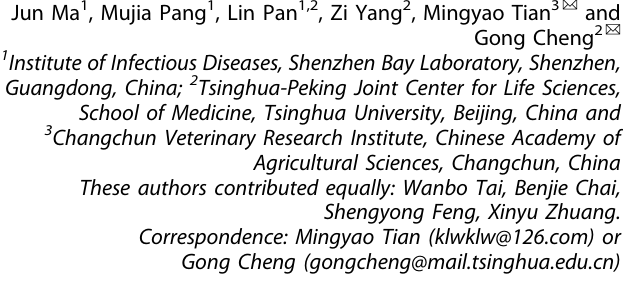
Fig. 1 Development and characterization of the FNP-Fc-RBDOmicron vaccine against SARS-CoV-2 Omicron variant. a Schematic representation of a SARS-CoV-2 Omicron RBD with Fc tag (light green), a ferritin-based 24-meric nanoparticle with N-terminal protein A tag (green), and an FNP-Fc-RBD Omicron complex. b The FNP complex was analyzed by SDS-PAGE. c Size distribution of the FNP complex was detected by DLS. d , e Interaction between Fc-RBD Omicron and FNP was detected by ELISA and SPR. An equal amount of ovalbumin served as a control. The data are presented as mean ± S.E.M. Statistical signi fi cance was calculated via ordinary unpaired parametric t test. f The FNP-Fc- RBD Omicron complex was analyzed by SDS-PAGE. g Size distribution of the FNP-Fc-RBD Omicorn was detected by DLS. h , i Measurement of IgG and neutralizing antibodies induced in immunized mice. The mice were immunized via intramuscular (i.m.) prime and boost at 2 weeks (10 μ g per mouse, n = 5). Sera at 14 days post-2nd immunization were detected for RBD Omicron -speci fi c IgG antibodies by ELISA. The neutralizing antibodies were assessed by live SARS-CoV-2 Omicron BA.1 virus. The data are presented as mean ± S.E.M. ( n = 5). Statistical signi fi cance was calculated via one-way ANOVA with multiple comparisons test. j Inhibition potency of immunized sera on SARS-CoV-2 RBD-hACE2 binding in hACE2/HEK293T cells. The inhibition potency was evaluated by fl ow cytometry. Inhibition percentage (%) was calculated by a relative fl uorescence intensity. k , l Splenocytes were stimulated with the RBD protein of Omicron. The IFN- γ and IL-4 secretion condition in splenocytes were detected by an ELISpot assay. Data represented as mean ± S.E.M. ( n = 5). Statistical signi fi cance was calculated via